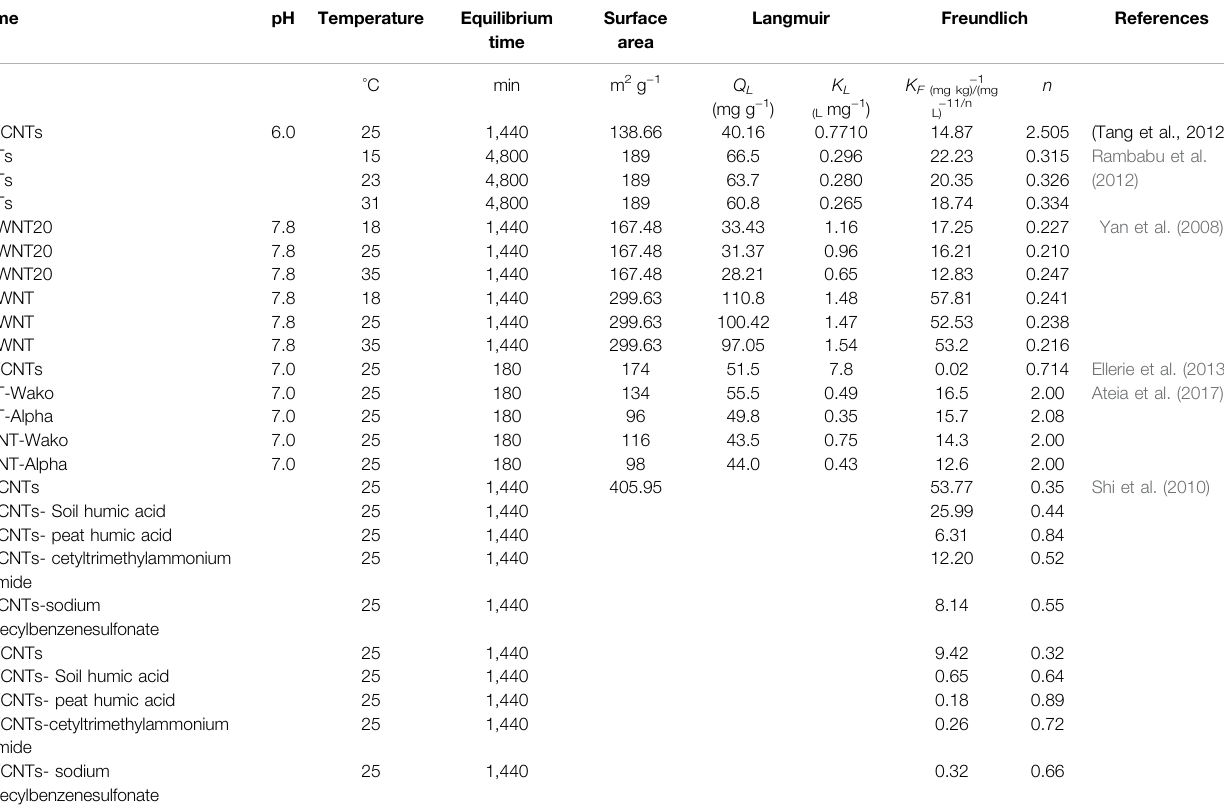
TABLE 3 | Ef fi ciency of various carbon nanotubes (CNTs), single-walled carbon nanotubes (SWCNTs), and multi-walled carbon nanotubes (MWCNTs) for the removal of atrazine from aqueous media as predicted by Langmuir and Freundlich